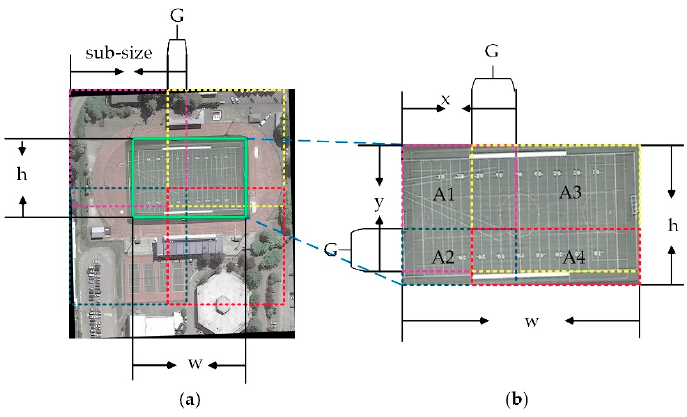
Figure 5. Calculation for adaptive adjustment rate. ( a ) An example of the splitting process. ( b ) A larger version of one object of ( a ).